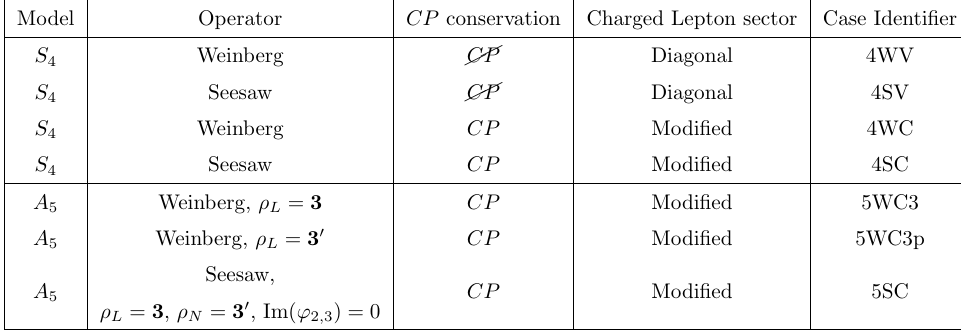
Table 5 . A list of the seven scenarios presented with good (cid:12)ts to data.